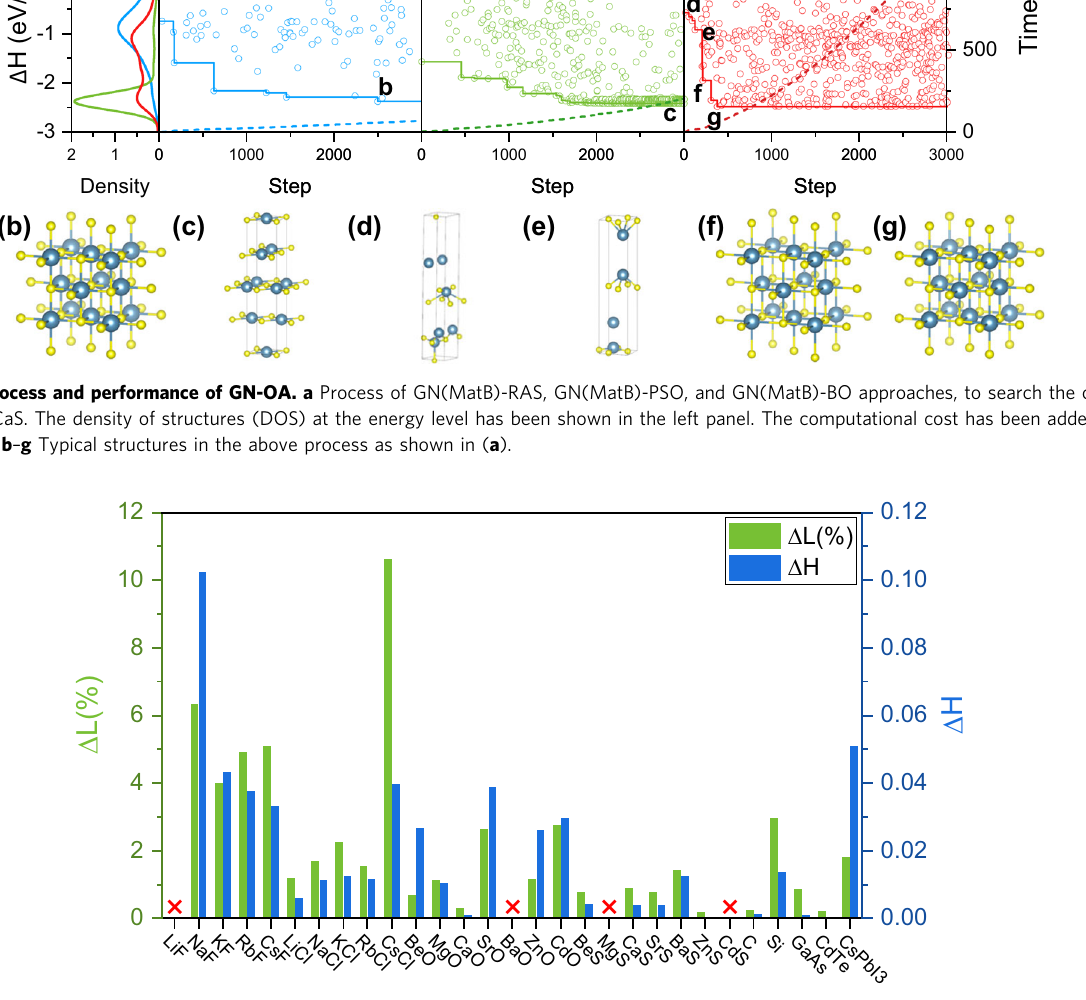
Fig. 4 The comparisons of GSS derived from GN-OA and DFT. The discrepancies of lattice constants and formation energies for 29 compounds predicted by GN(MatB)-BO approach in comparison to DFT-calculated results. The red cross mark means that GN(MatB)-BO predicted wrong GSS in comparison to DFT